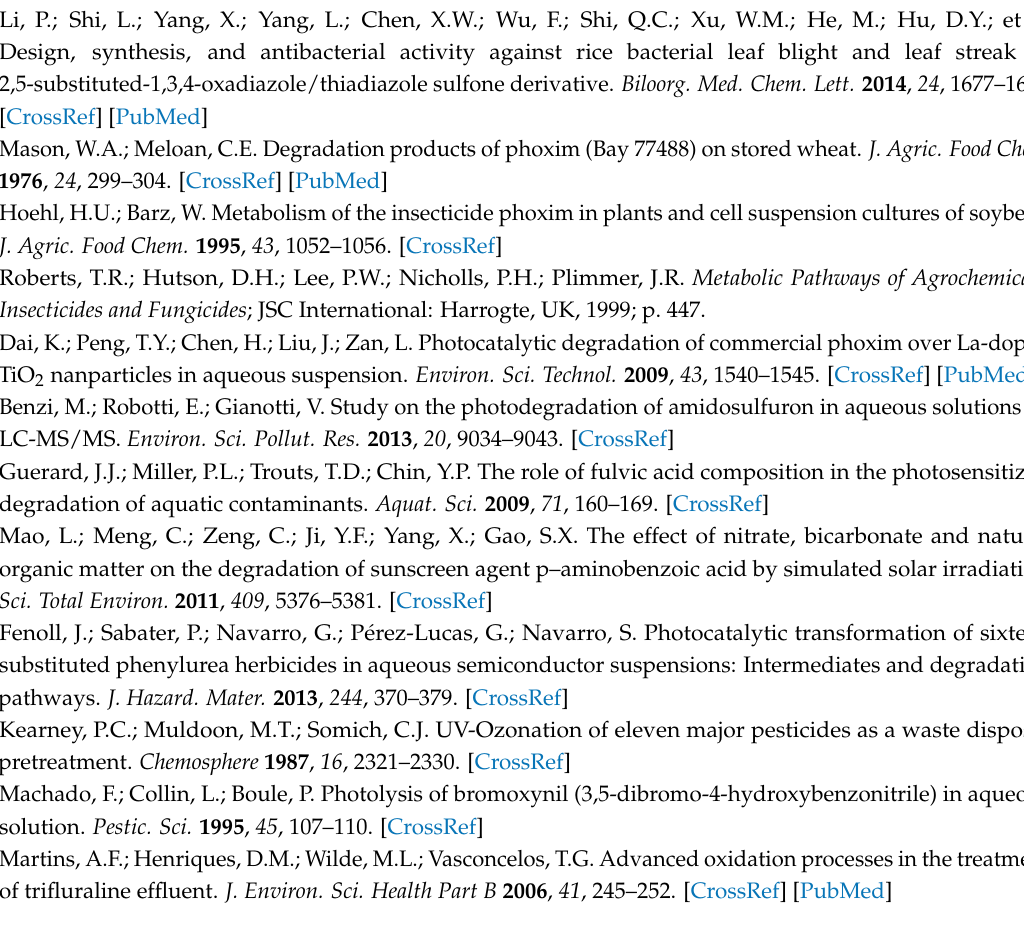
Table S2. Hydrolysis parameters of FBEZF with different initial concentrations in water. Table S3. Hydrolysis parameters of FBEZF in water under different temperature; Table S4. Photolysis parameters of FBEZF with different initial concentrations in